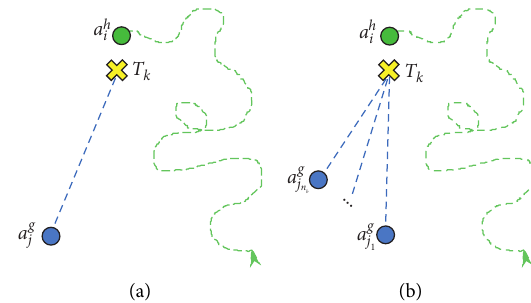
Figure 2: Possible scenarios: (a) reverse auction scenario and (b) auction scenario.